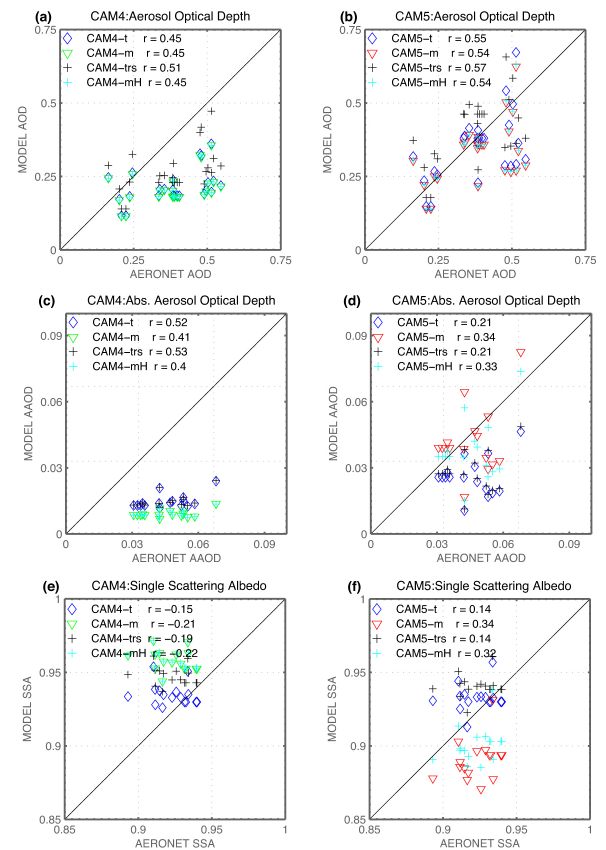
Figure 15. Annually averaged modeled aerosol optical depth (a, b) , absorbing aerosol optical depth (c, d) and single scattering albedo (e, f) compared to annually averaged AERONET retrievals at 533nm at sites where modeled AOD dust >AOD total · 0.5. CAM4 (a, c, e) and CAM5 (b, d, f) are shown for tuned dust, mineralogy, tuned dust + release size and mineralogy with hematite in soil clay